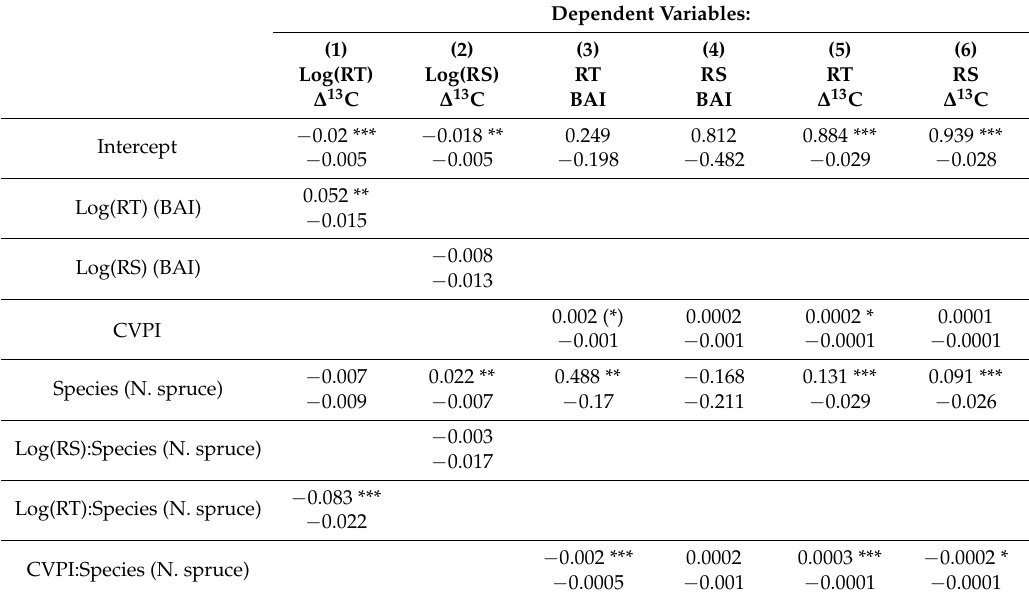
Table 5. Means of RT and RS, differences between means, and significance levels (linear mixed effect model) of ∆ 13 C and BAI. Species and mixture situation are independent variables. Significance